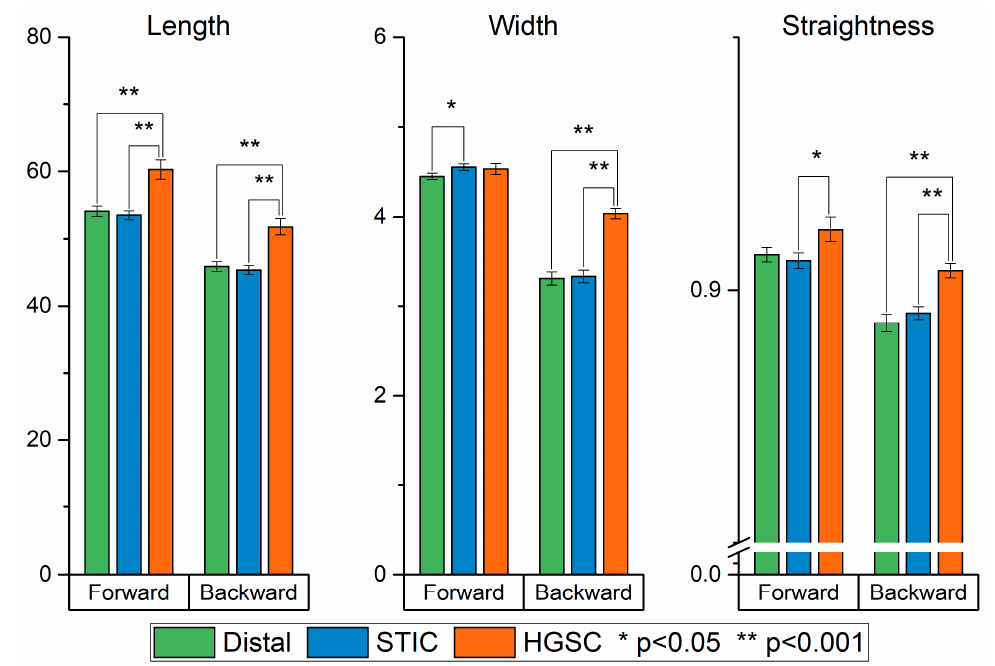
Figure 6. Bar plots of the mean value for each group in all three of the outputs calculated in the CT-FIRE analysis. (*) and (**) correspond to p < 0.05 and p < 0.001, respectively. Overall, these results mirror the output of the texture features from the GLCM in Section 2.2.